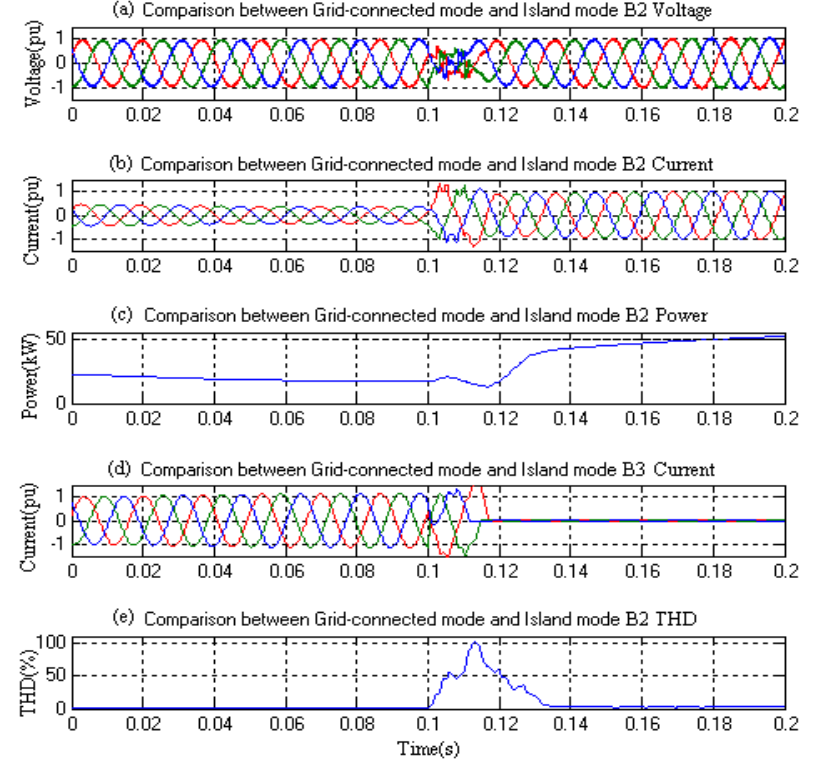
Figure 9. The circuit analysis of the transition from grid-connected mode to island mode (a) B2 Voltage (b) B2 Current (c) B2 Power (d) B3 Current (e) B2 total harmonic distortion (THD) of